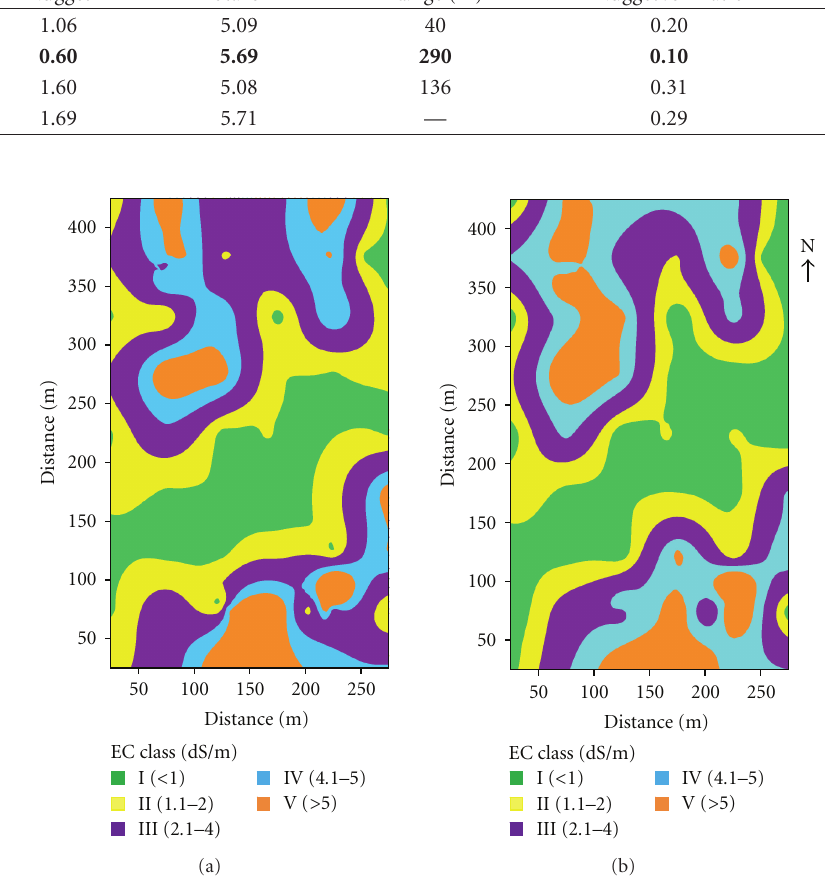
Figure 4: EC class spatial distribution contour map (a) 0–20 cm depth, (b) 20–40 cm depth during